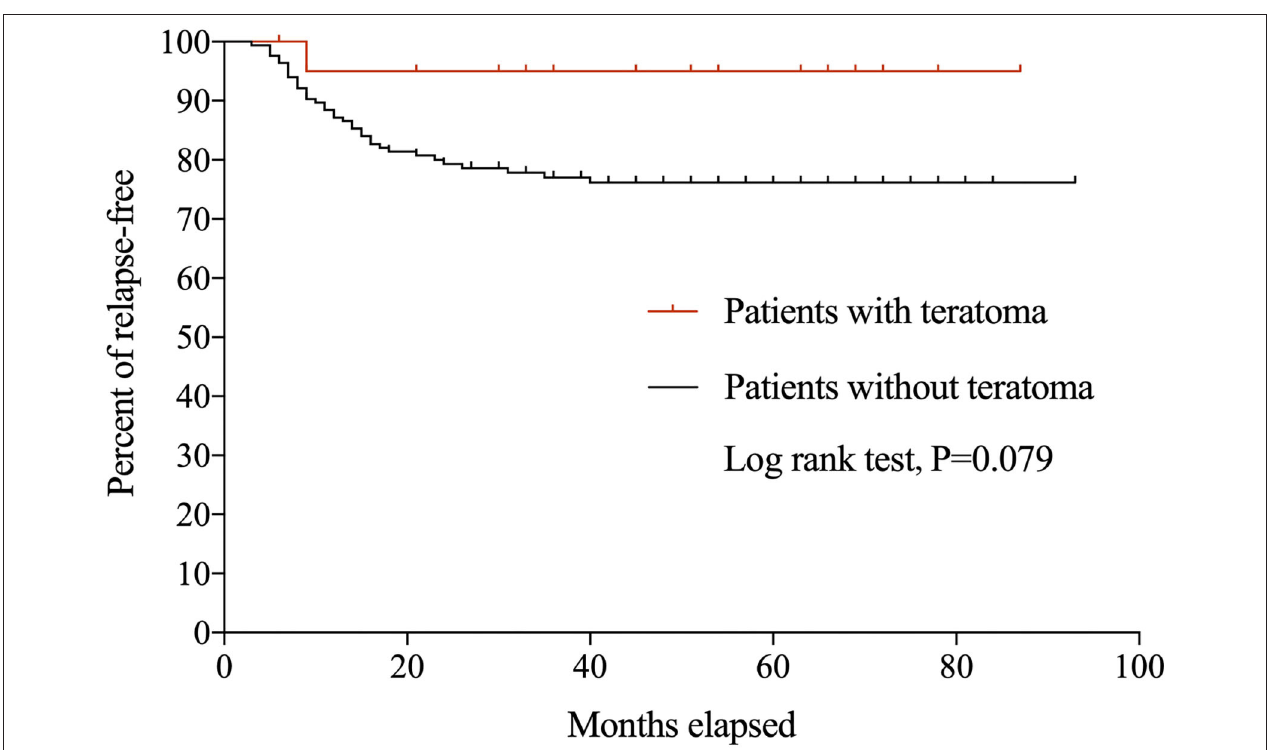
FIGURE 1 | Kaplan-Meier curves for anti-NMDAR encephalitis patients with and without